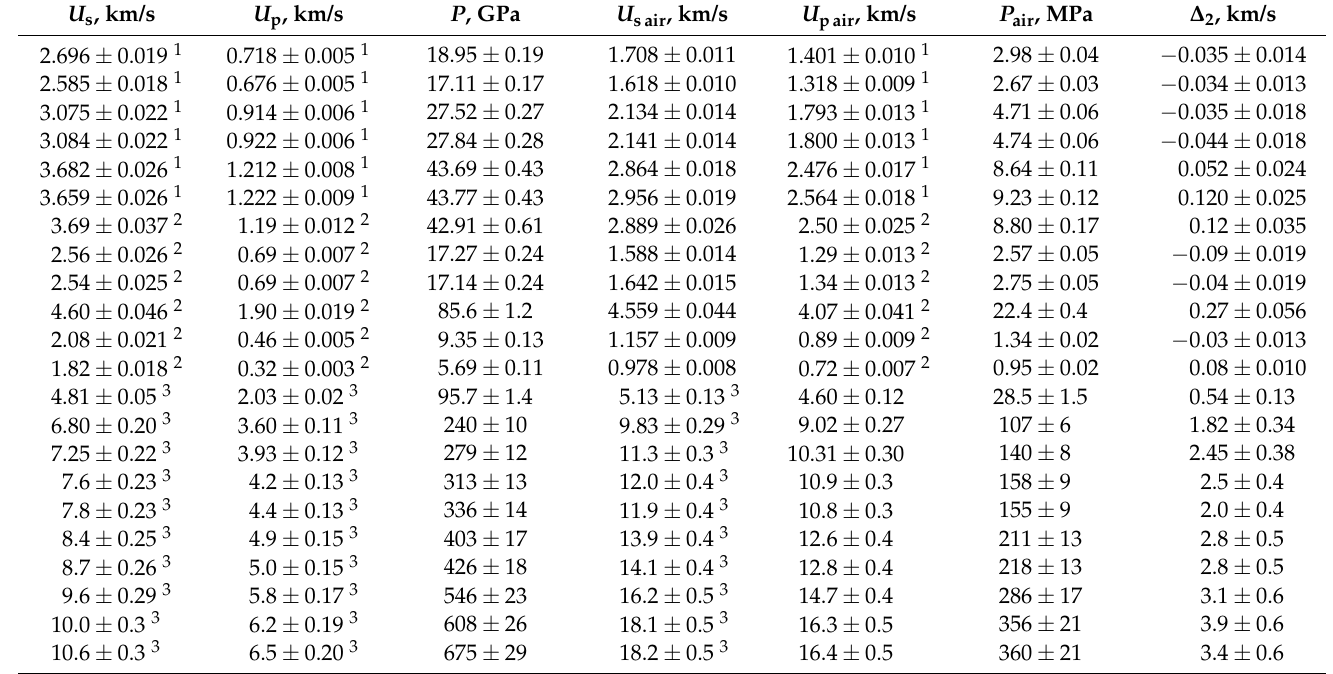
Table 1. Data on isentropic release of shock-compressed bismuth samples into air: U s , U p , and P are the shock and particle velocities and the pressure behind the front of the first shock wave in the bismuth samples; U sair , U pair , and P air are the shock and particle velocities and the pressure behind the front of the shock wave in air; ∆ 2 = U pair − 2 U p